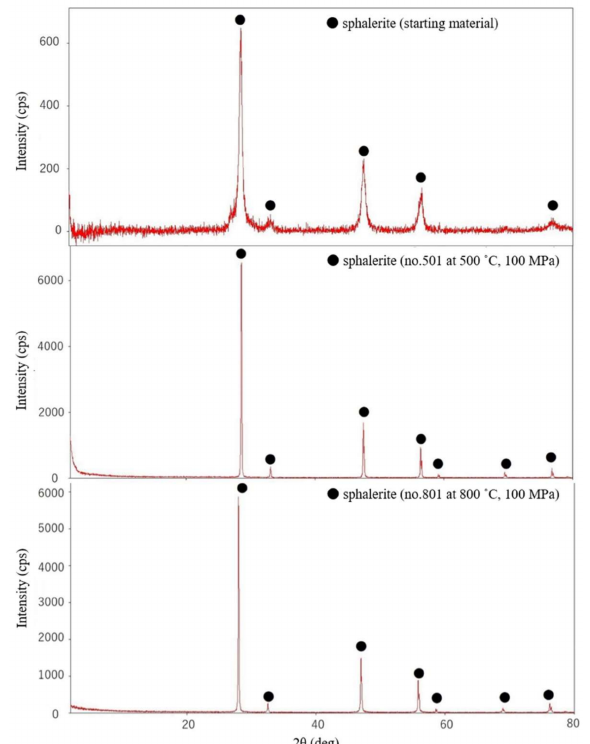
Figure 1. Powder X-ray diffraction patterns of starting material (ZnS) and synthesized solid run